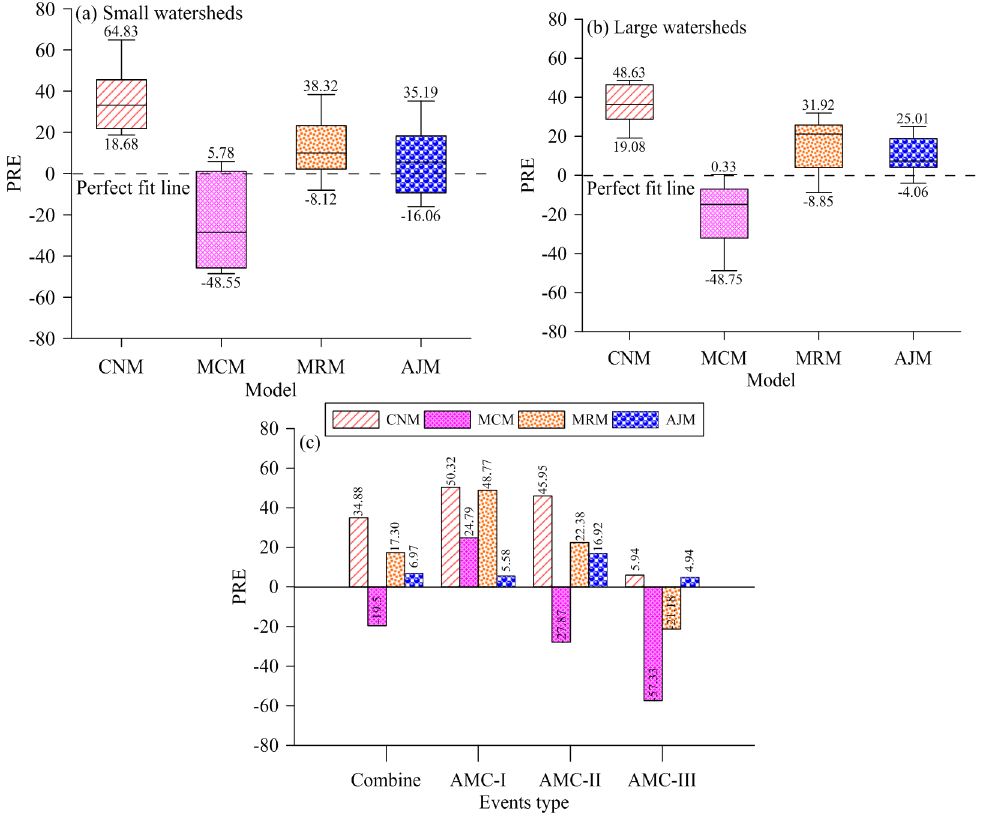
Figure 5. Model performance based on Percent Relative Error (PRE) ( a ) in small watersheds (Area ≤ 250 km 2 ); ( b ) in larger watersheds (Area > 250 km 2 ); and ( c ) for different types of events (dry, normal and wet).